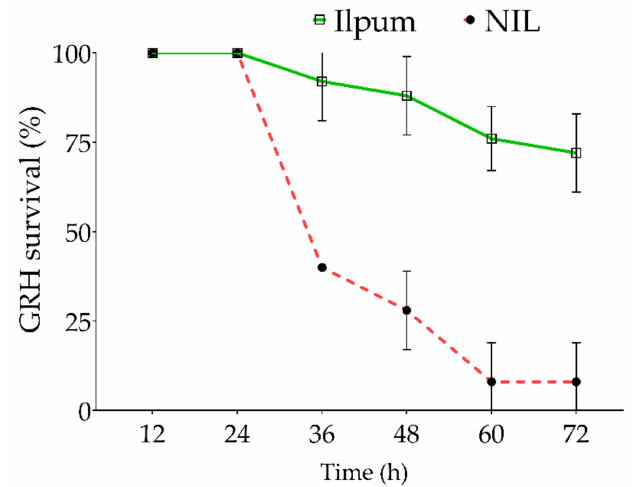
Figure 2. Survival percentage of green rice leafhopper over time. Ten green rice leafhoppers (GRHs) were placed in each test tube containing a single rice seedling. The number of alive GRHs was counted every 12 h from the initial infestation time, and the survival percentage was estimated for each time point. The red dotted line indicates the near-isogenic line (NIL, a cross between Shingwang carrying Grh1 locus and Ilpum) GRH-infested, while the green continuous line represents the survival of Ilpum GRH-infested. Error bars denote the SD of mean values (10 insects per tube) in